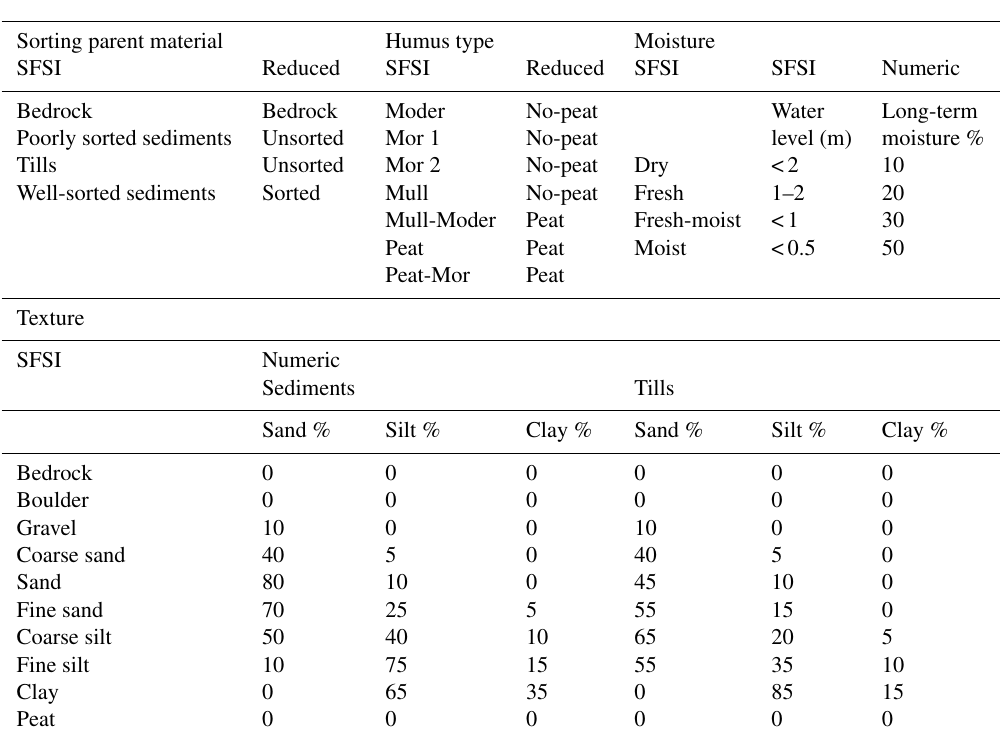
Table 1. Description of the Swedish Forest Soil Inventory (SFSI) data reduction of soil sorting of parent material and humus types; SFSI conversion estimate of soil classes of soil moisture to numerical representation of soil water content; and SFSI conversion estimate of classes to numerical representation of soil texture (sand, silt, and clay content for sediments by Lindén (2002) and for tills by Albert Atterberg’s distribution of the different grain size